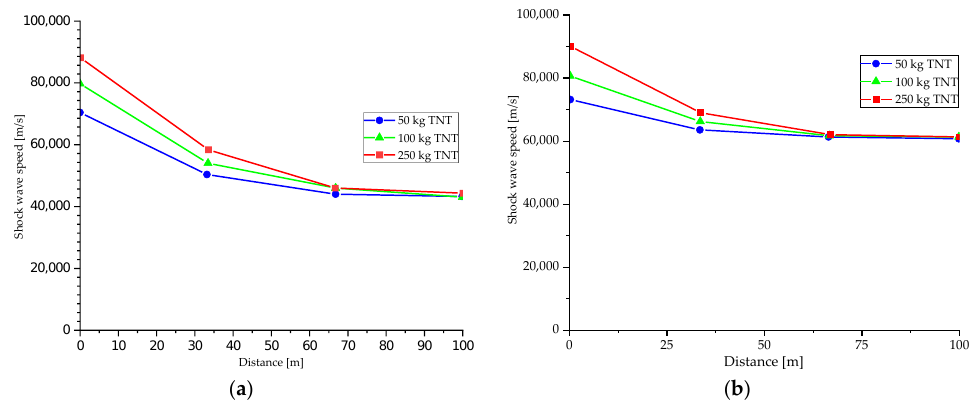
Figure 8. Shock wave propagation speed variation ( a ) in sandy soils ( b ) in clay soils.